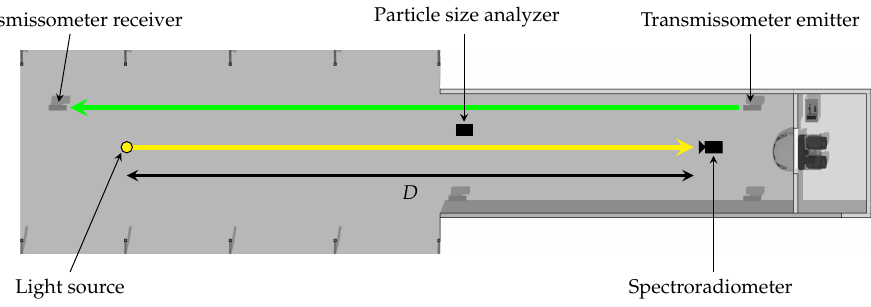
Figure 6. Protocol used to measure the extinction coefficient on the PAVIN BP